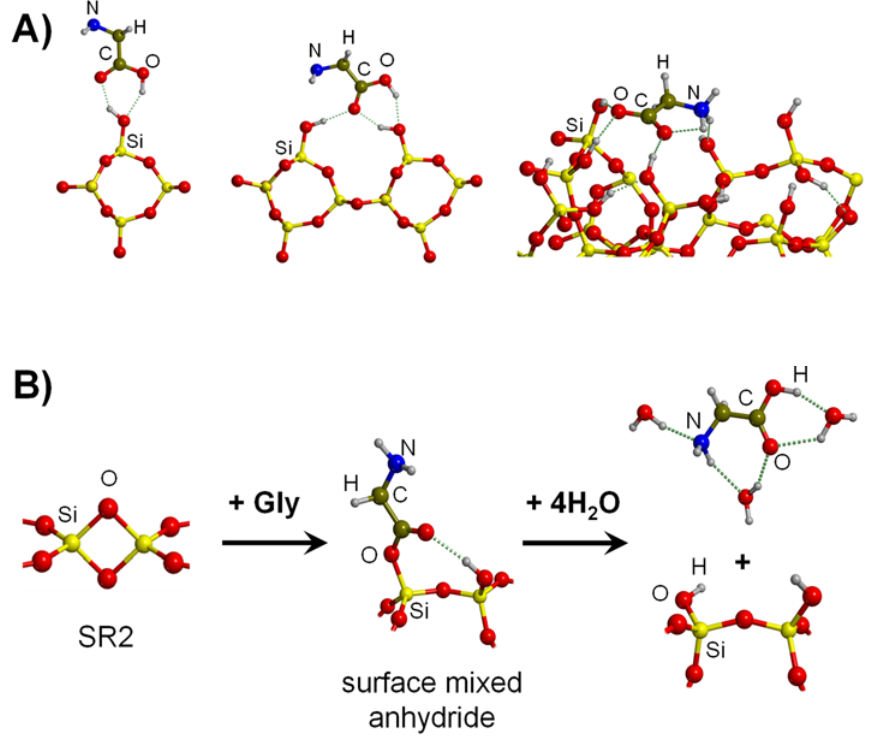
Figure 4. ( A ) Different complexes formed from the interaction of Gly with silica surfaces (adapted from Ref. [119]). ( B ) Reaction of Gly with silica S2R surface defect to form a surface mixed anhydride, and the subsequent release of Gly by the action of water (adapted from Ref. [151]).